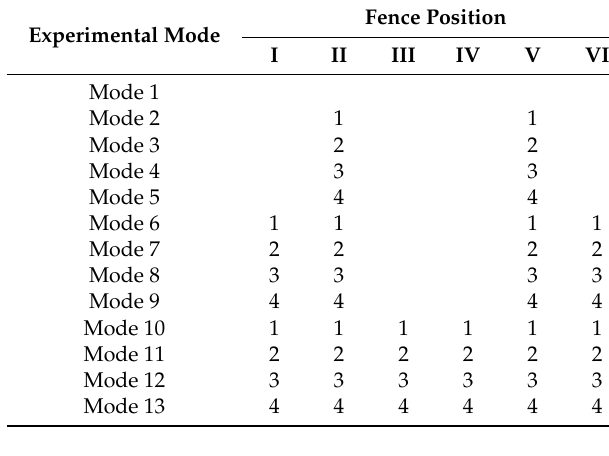
Table 1. Details of 13 different modes of river-bed conditions.